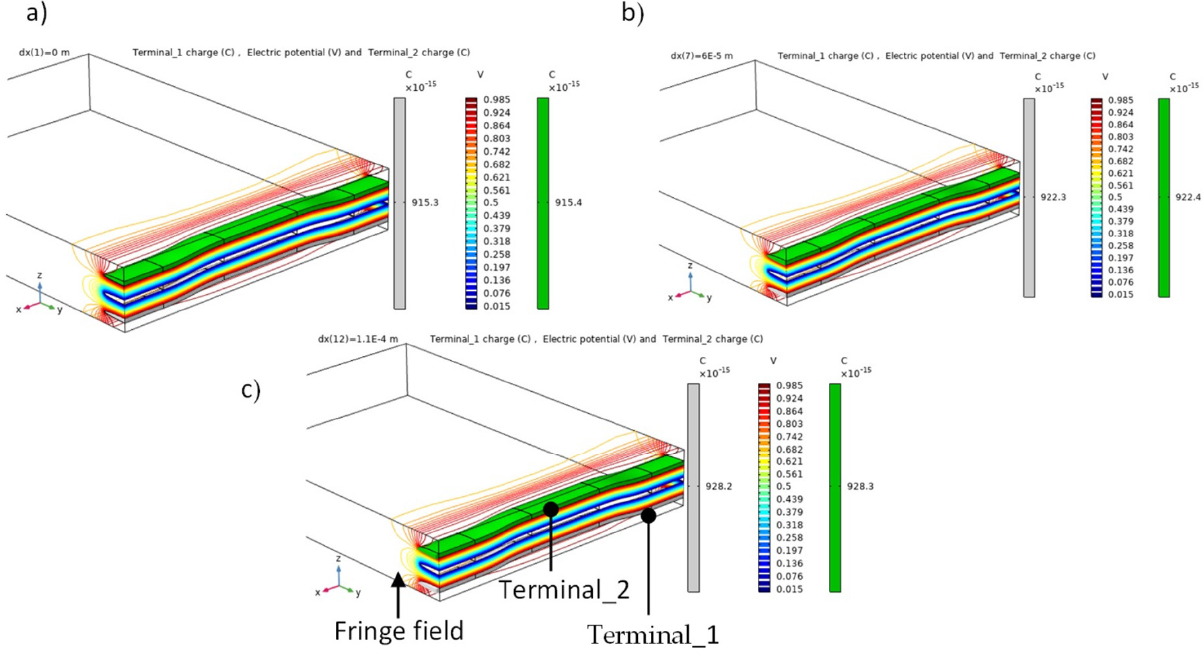
Figure 11. Electric potential (V) contour shows the distribution through the thickness of the unit cell at ( a ) zero axial load where the initial capacitance for terminal_1 and tramnial_2 was 0.91 pF, ( b ) 60 µ m axial tensile displacement and the predicated capacitance was 0.922 pF, and ( c ) 110 µ m axial tensile displacement and the predicated capacitance was 0.928 pF. To obtain capacitance (C) using FEA, the electric charge (Q) was divided by the electric potential (V = 1 V).